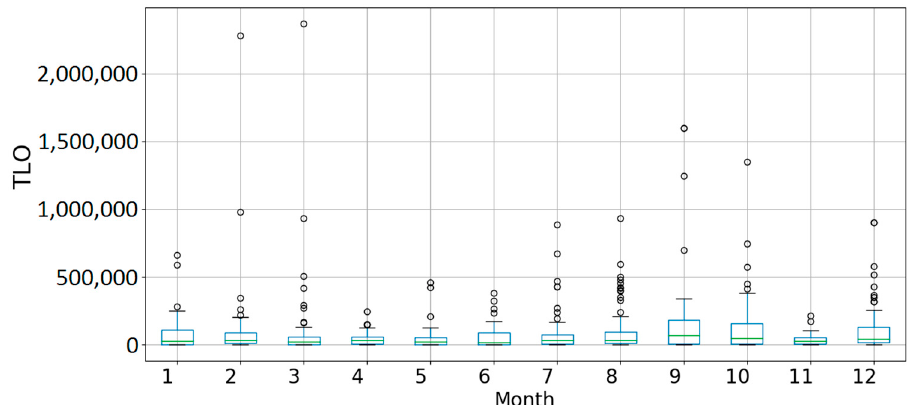
Figure 9. Monthly distribution of total revenue loss (USD millions) due to power outages in the top 10 most affected states of the U.S. [29].